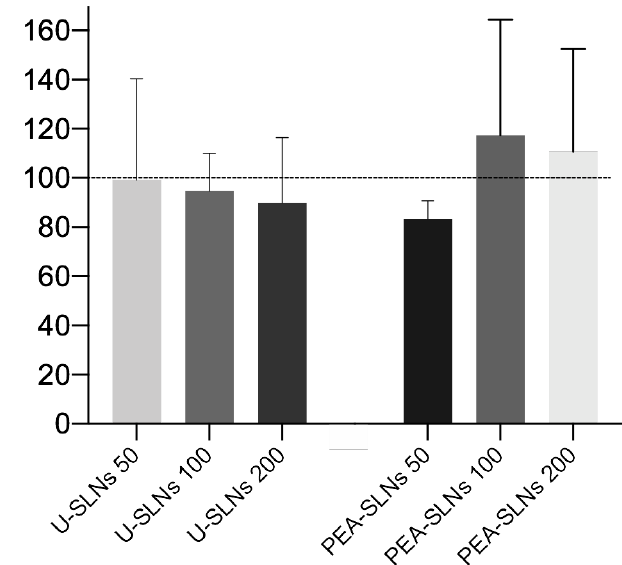
Figure 5. Cytotoxicity of U-SLNs and PEA-SLNs at the concentrations of 50, 100, and 200 µg/mL on C2C12 cell line at 24 h incubation, expressed as cell viability percentage (dotted line as the control).